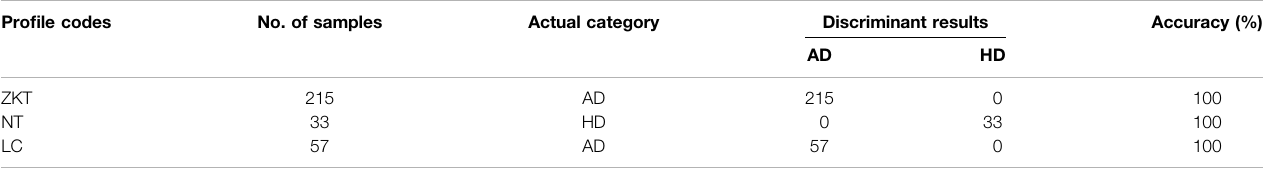
TABLE 4 | The veri fi cation of the discriminant